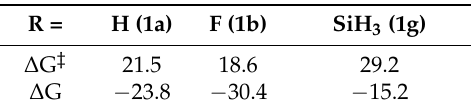
Table 1. Activation ( ∆ G ‡ ) and reaction ( ∆ G) free energies (kcal/mol) for the dimerization of three selected siloles following a [4 + 2] cycloaddition path 1 .